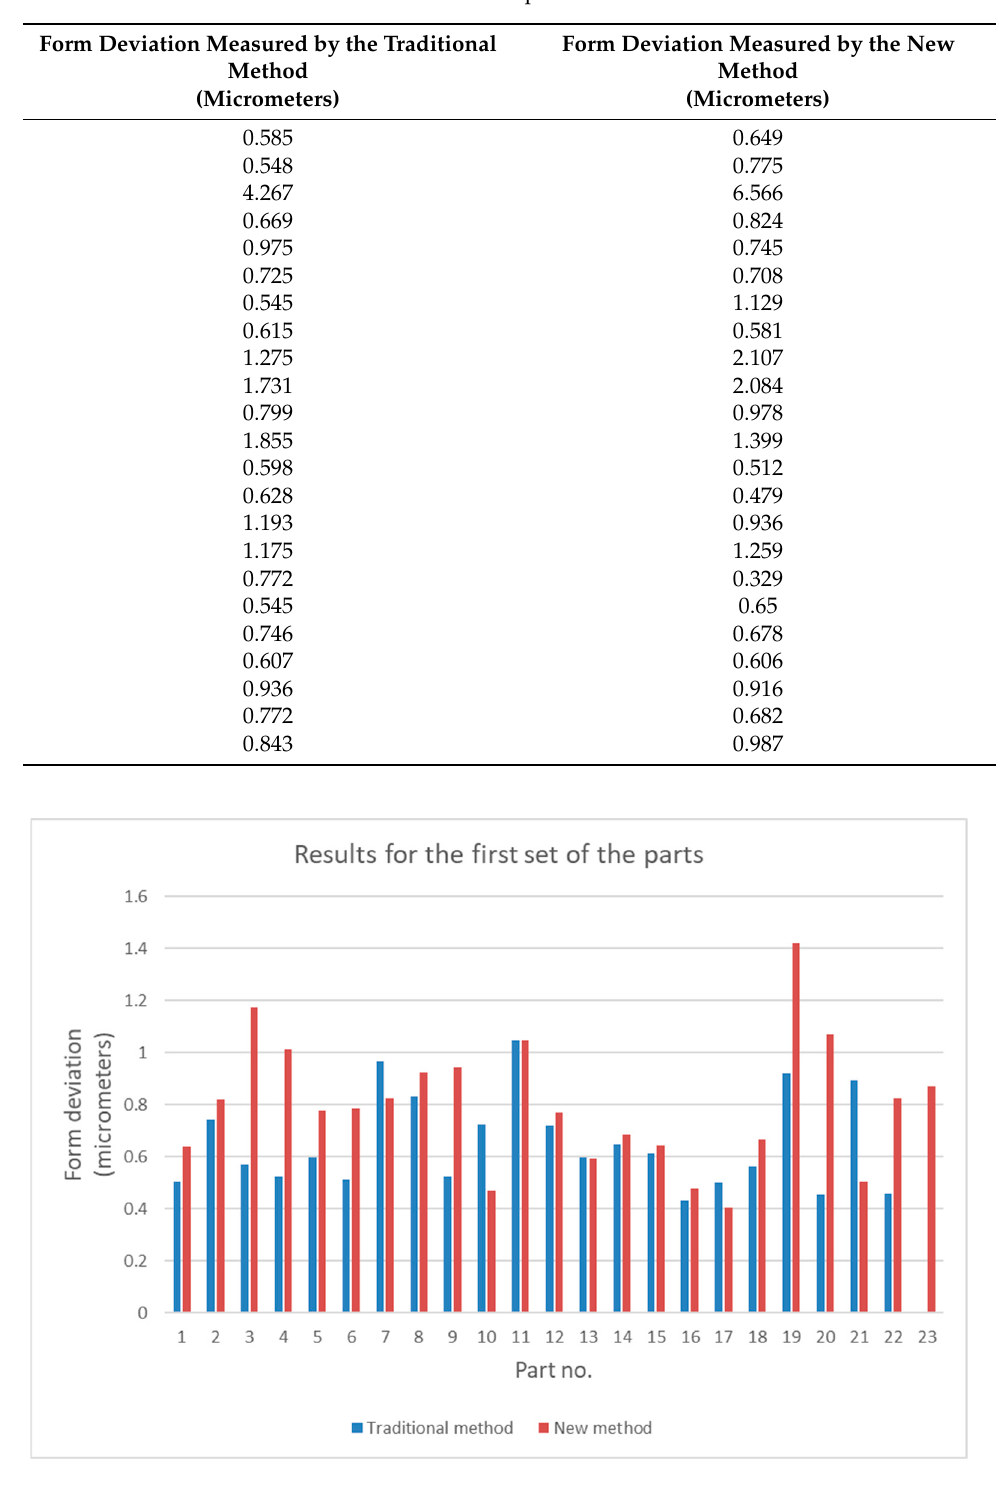
Figure 5. Comparison of form deviations obtained by the traditional and by the new method for the second set of parts.